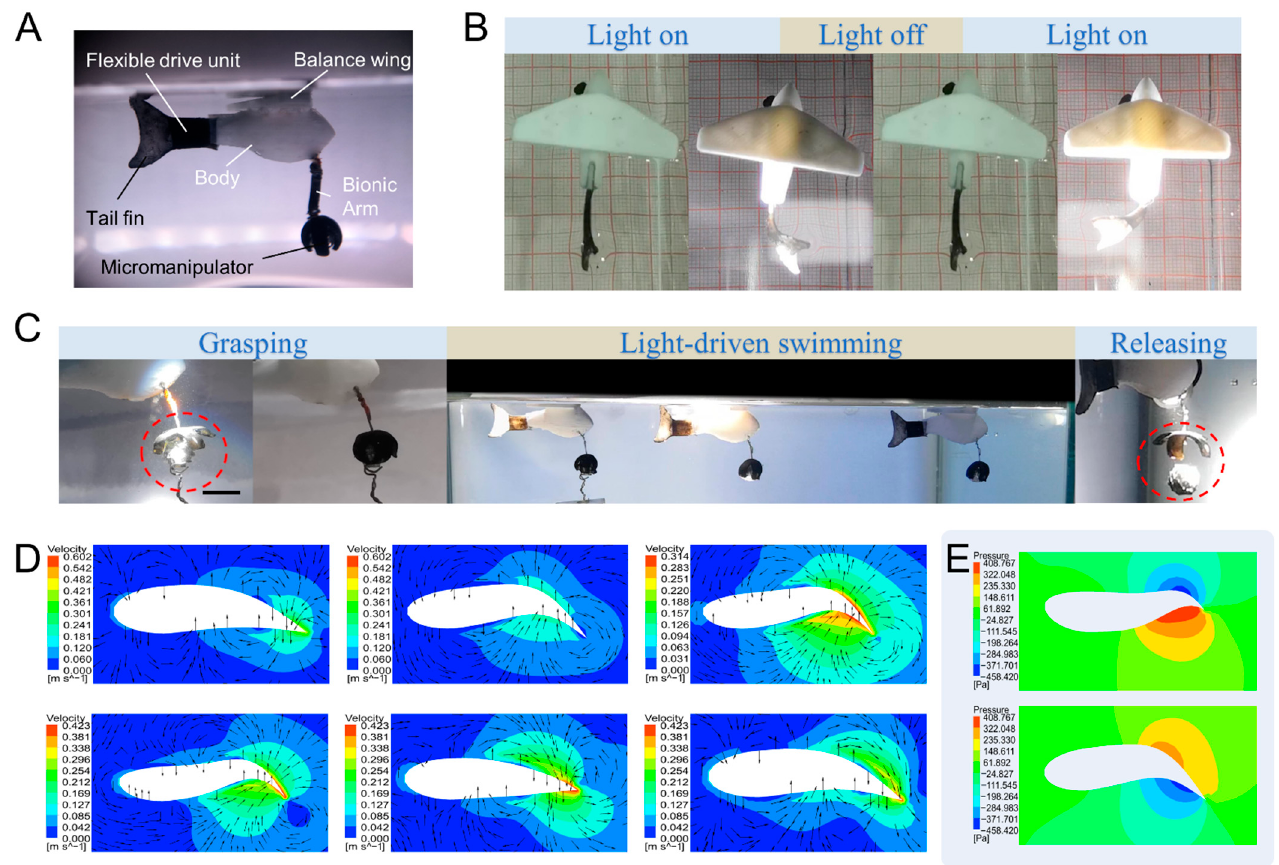
Figure 6. ( A ) The main components of the light-driven microfish. ( B ) Alternating left and right illumination of the light source to realize the attitude adjustment of the fish tail swaying from left to right. ( C ) The light-driven microfish realizes the task of carrying objects from the starting point to the end point. The light-driven grasping of the goods is realized at the starting point, the light-driven the microfish swim, and then the light-driven release of the goods is realized at the end point. ( D ) Finite element analysis of velocity field of fish swimming. ( E ) Pressure field analysis of fish swimming (Scale bar is 5 mm).